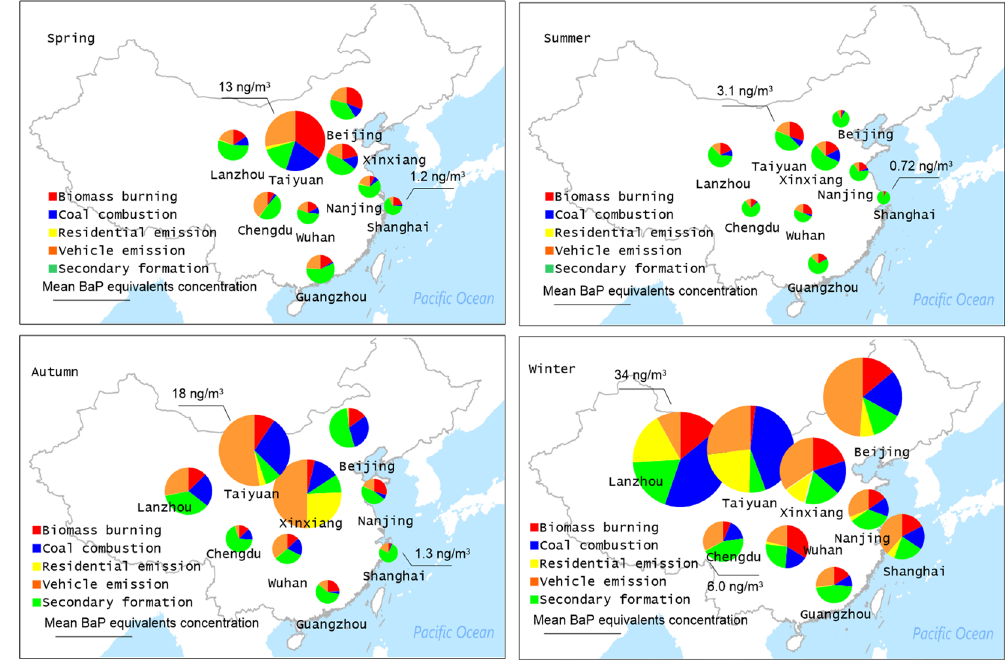
Figure 6. Contributions of the five sources to the BaPeq concentrations of the total PAHs in PM2.5 at 9 urban cities over four seasons. (the background map was made using surfer 8.0 by one